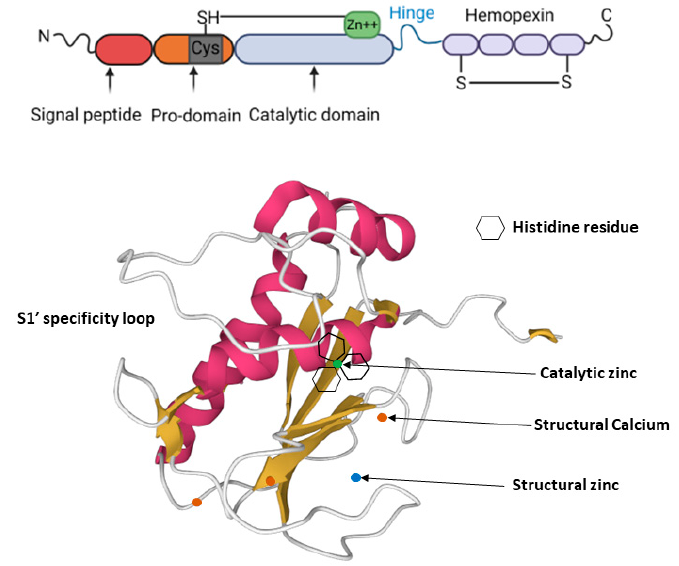
Figure 1. MMP-13 structure: MMP-13 consists of a highly conserved signal peptide, a pro-domain, a catalytic domain, a proline-rich hinge region and a C-terminal hemopexin-like domain (top panel). The cysteine residue (Cys 77) shown in grey within the pro-domain is linked to the catalytic zinc ion within the catalytic domain in pro-active MMP-13. The bottom panel shows the MMP-13 catalytic domain (PDB 2OW9). The structural zinc ion is in blue, the catalytic zinc ion is in green, and the three calcium ions are in orange. Three histidine residues, which bind to the catalytic zinc ion, are shown as